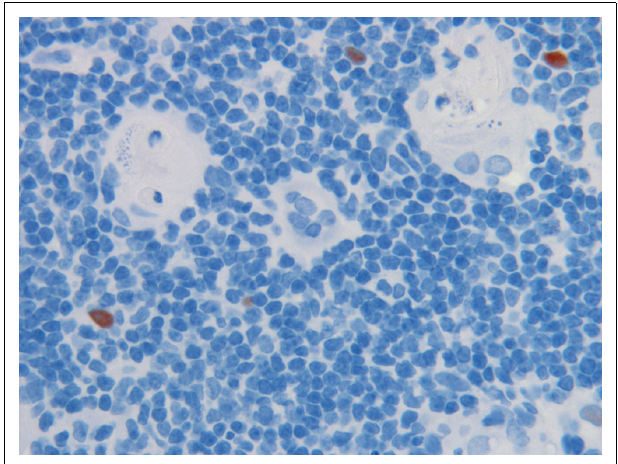
FIGURE 1 | Medullary epithelia cells in thymus, expressing theAIRE proteins (reddish brown), in close vicinity of the Hassall’s corpuscles (HC) where auto-reactiveT cells are thought to be destroyed. Note cell debris in HC. Magnification 1:40. AIRE was demonstrated with specific monoclonal antibody at 1:2,000